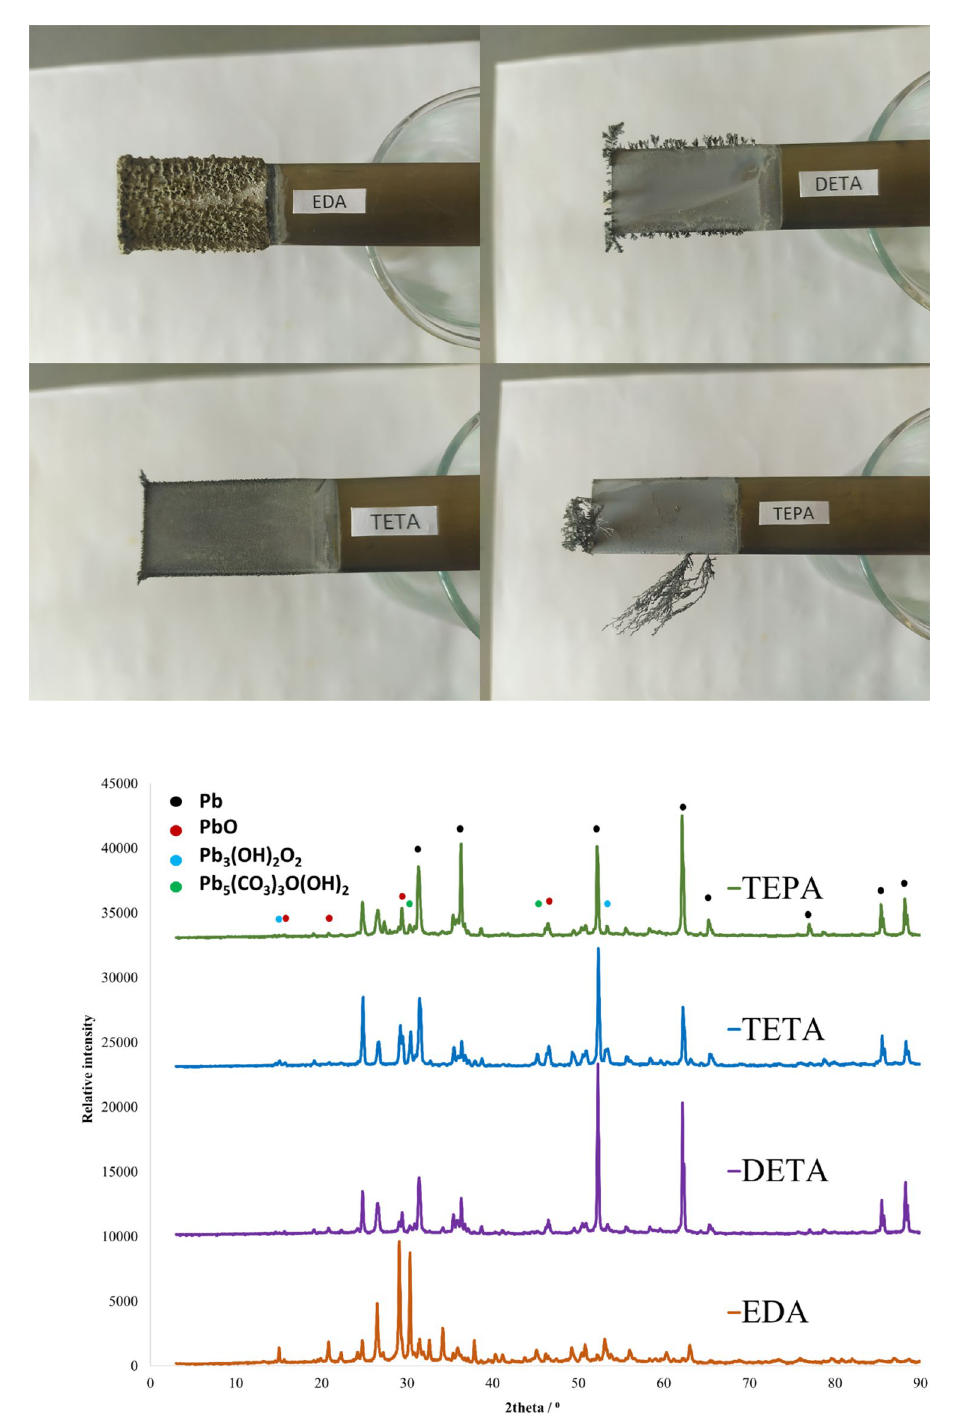
Fig. 1 Appearance of cathodic deposits of lead metal obtained from different poly- amine electrolytes